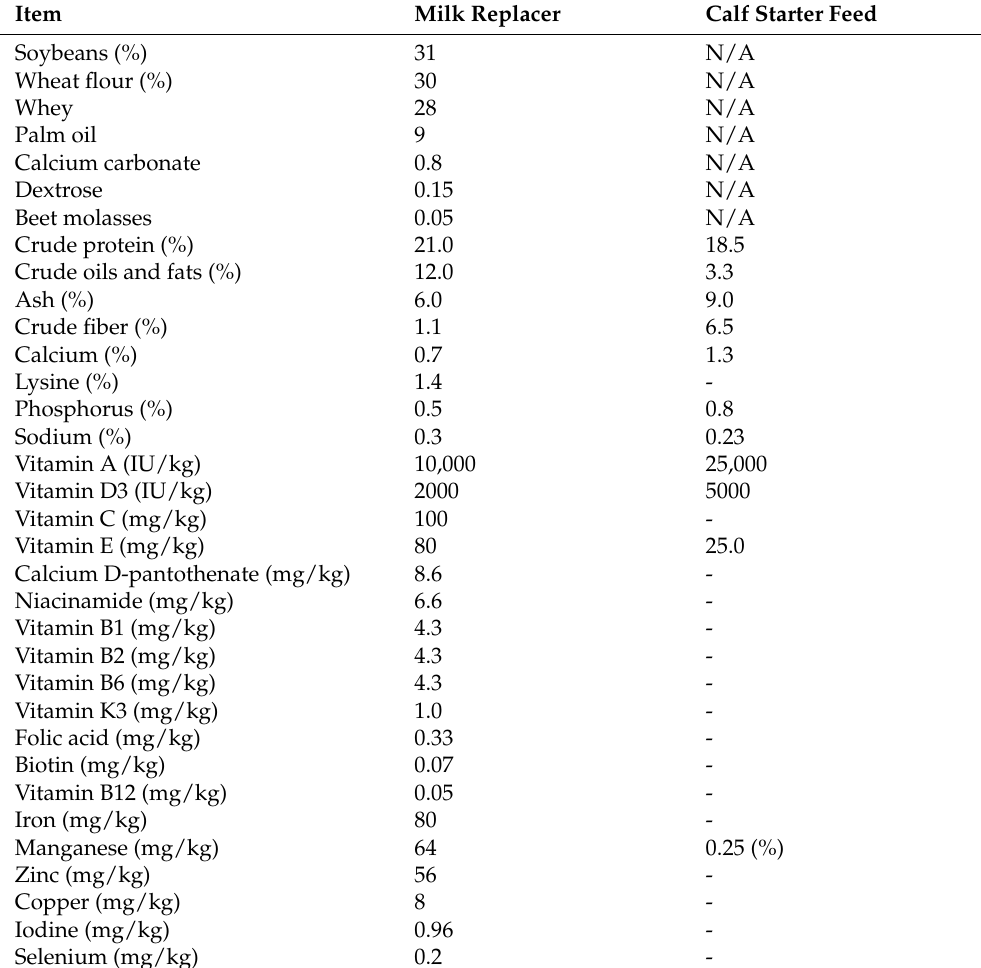
Table 2. Ingredients and nutrient and chemical composition of the standard diet (on feed basis) of experimental and control